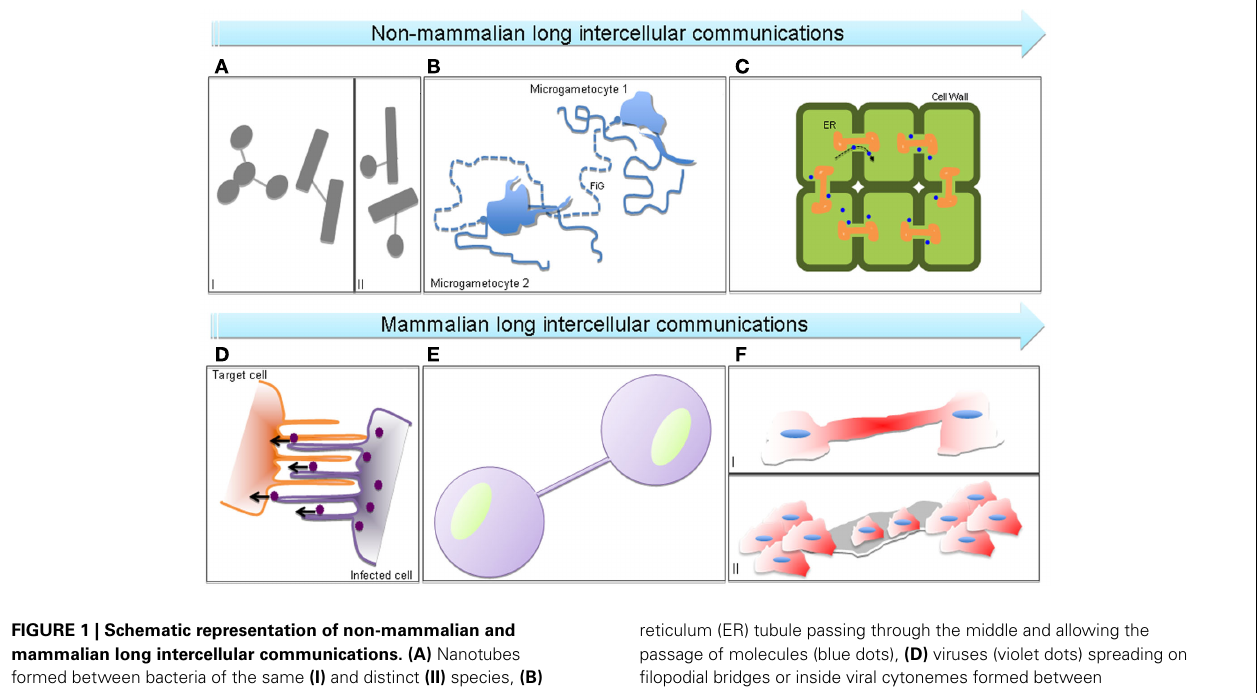
FIGURE 1 | Schematic representation of non-mammalian and mammalian long intercellular communications. (A) Nanotubes formed between bacteria of the same (I) and distinct (II) species, (B) filamentous connection (FiG) between extra flagellating microgametocytes (malaria sexual stage parasites), (C) plasmodesmata connecting neighboring plant cells, constituted by a membrane-lined cytoplasmic channel traversing the cell wall with an endoplasmic